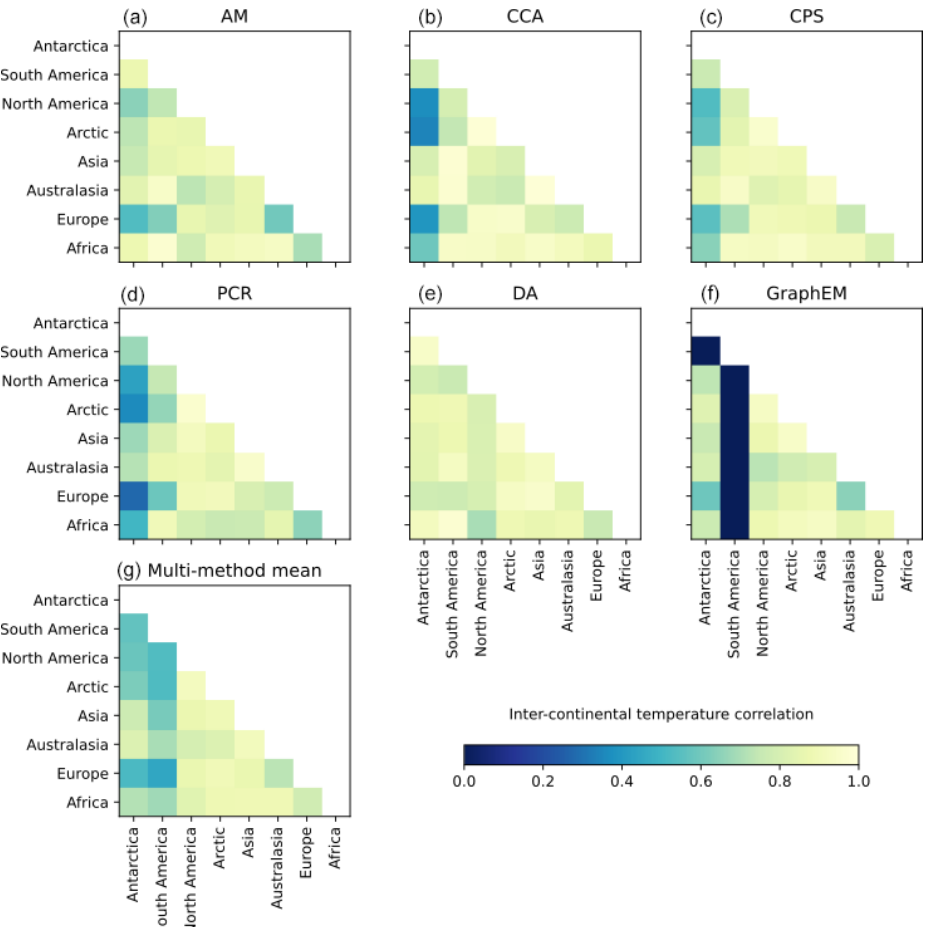
Figure A4. PAGES-2k (Neukom et al., 2019) inter-regional temperature correlations for the individual CFR methods. In contrast to Fig. 6, ensemble mean temperature time series per grid cell are used here as the basis to calculate inter-regional temperature correlations for the different CFRs. The multi-method mean is shown in (g) . Note that these results are non-lagged correlations.